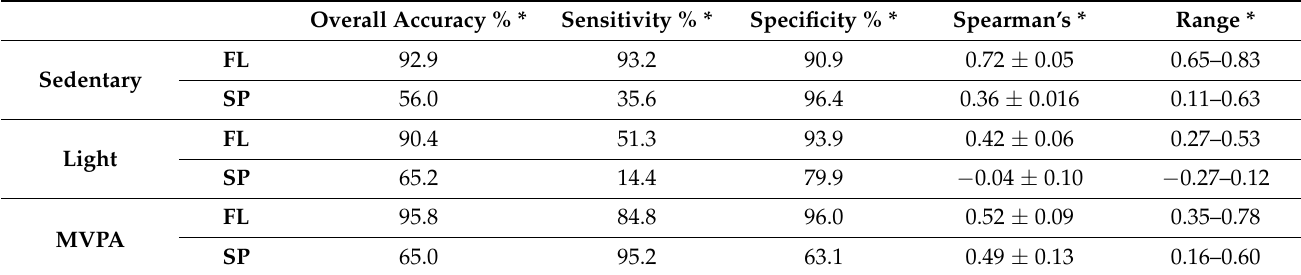
Table 2. Overall accuracy, sensitivity and specificity comparative performance and Spearman’s correlation coefficient and range values of Verisense in detecting PA levels during FL and SP, in comparison to Actiwatch 2.